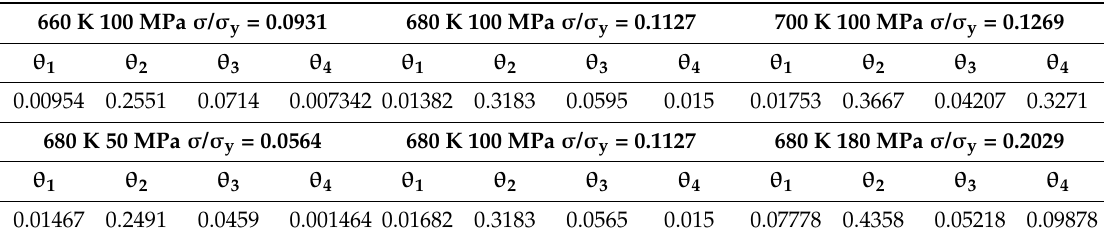
Table 1. Values of the total primary strain θ 1 , tertiary strain θ 3 , and rate parameters governing curvatures of the primary ( θ 2 ) and tertiary ( θ 4 ) components at different creep